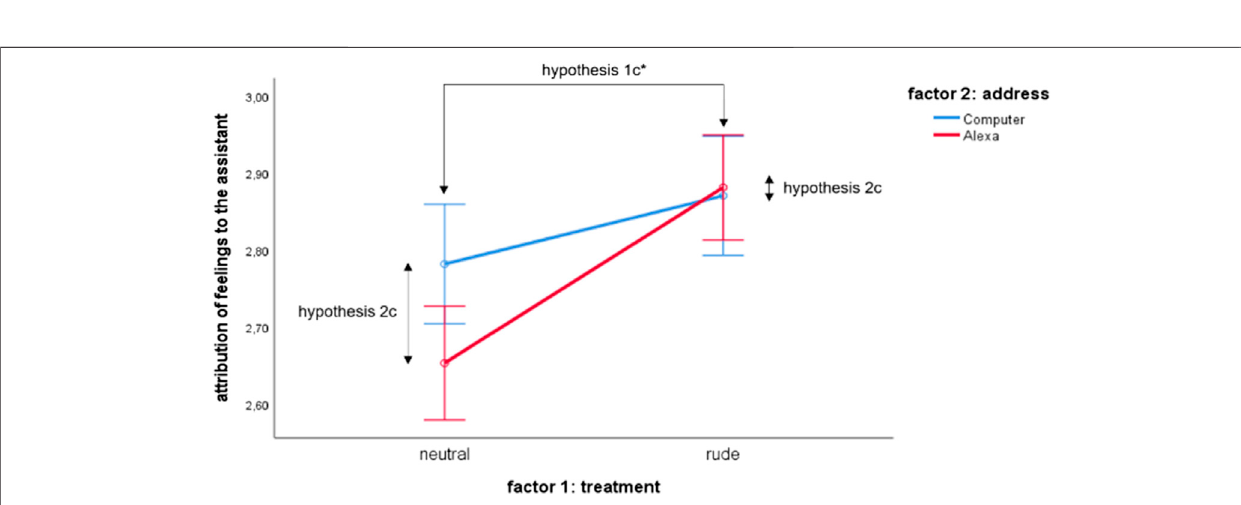
FIGURE 4 | Effects of treatment and form of address on attribution of feelings to the CA (controlled for trait empathy).